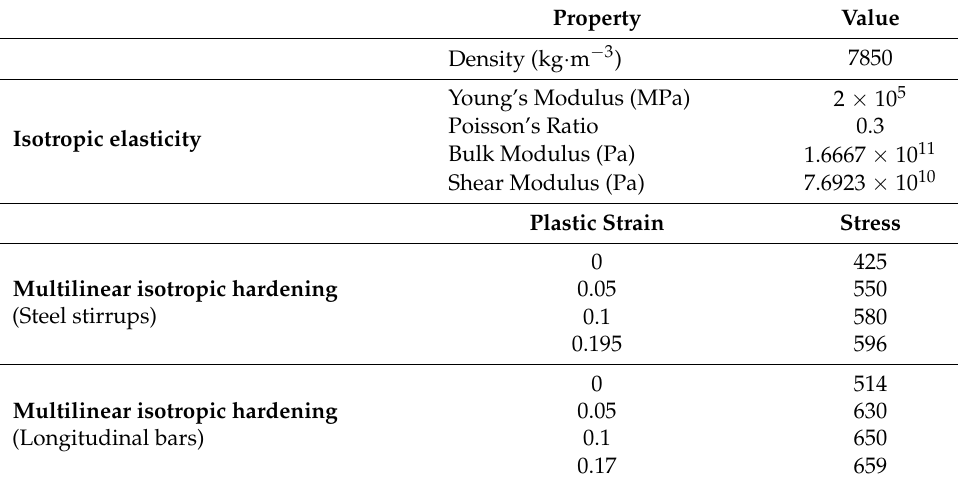
Table 3. Basic steel material